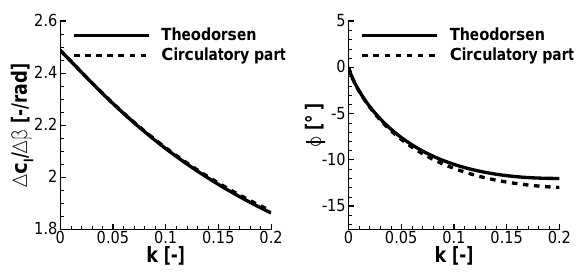
Figure 3. Lift amplitude in relation to flap amplitude (cid:49)c l /(cid:49)β and phase shift according to